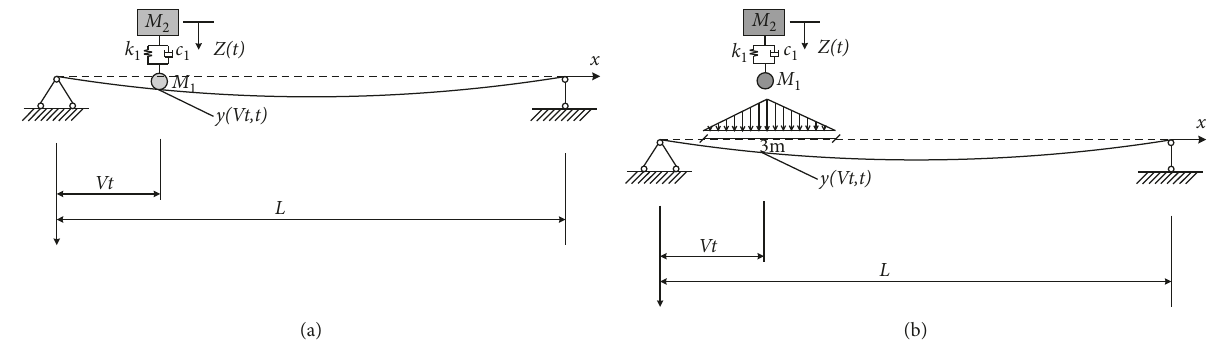
Figure 4: Moving oscillator models. (a) Point load. (b) Spread